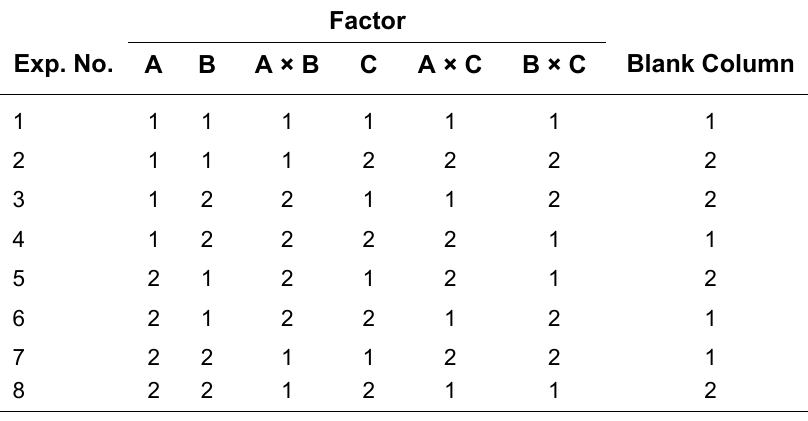
Arrangement of Factors and Levels in Orthogonal